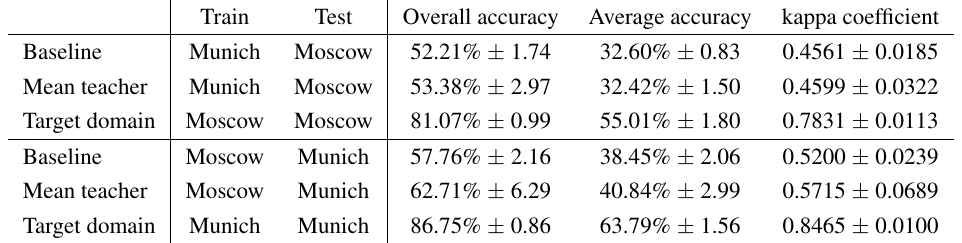
Table 1. Number of reference data of classes for both cities.